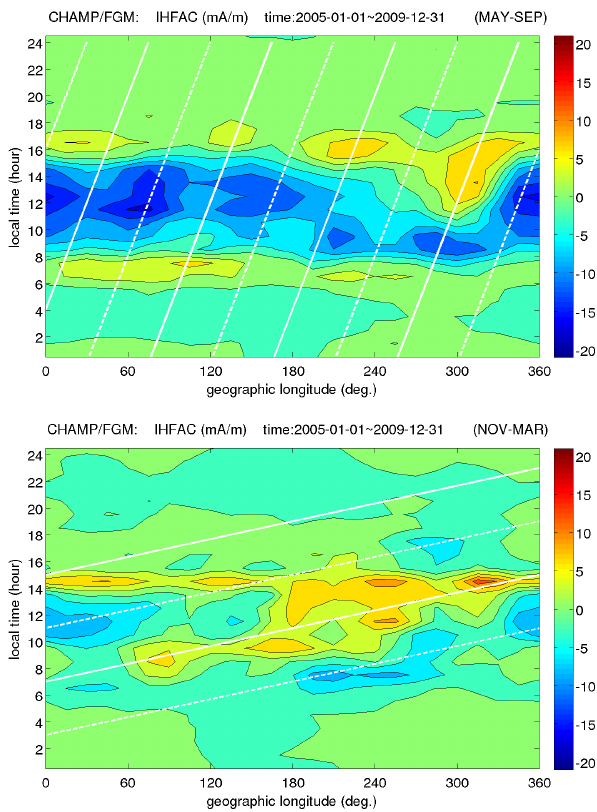
Fig. 6. The same as Fig. 5, but for